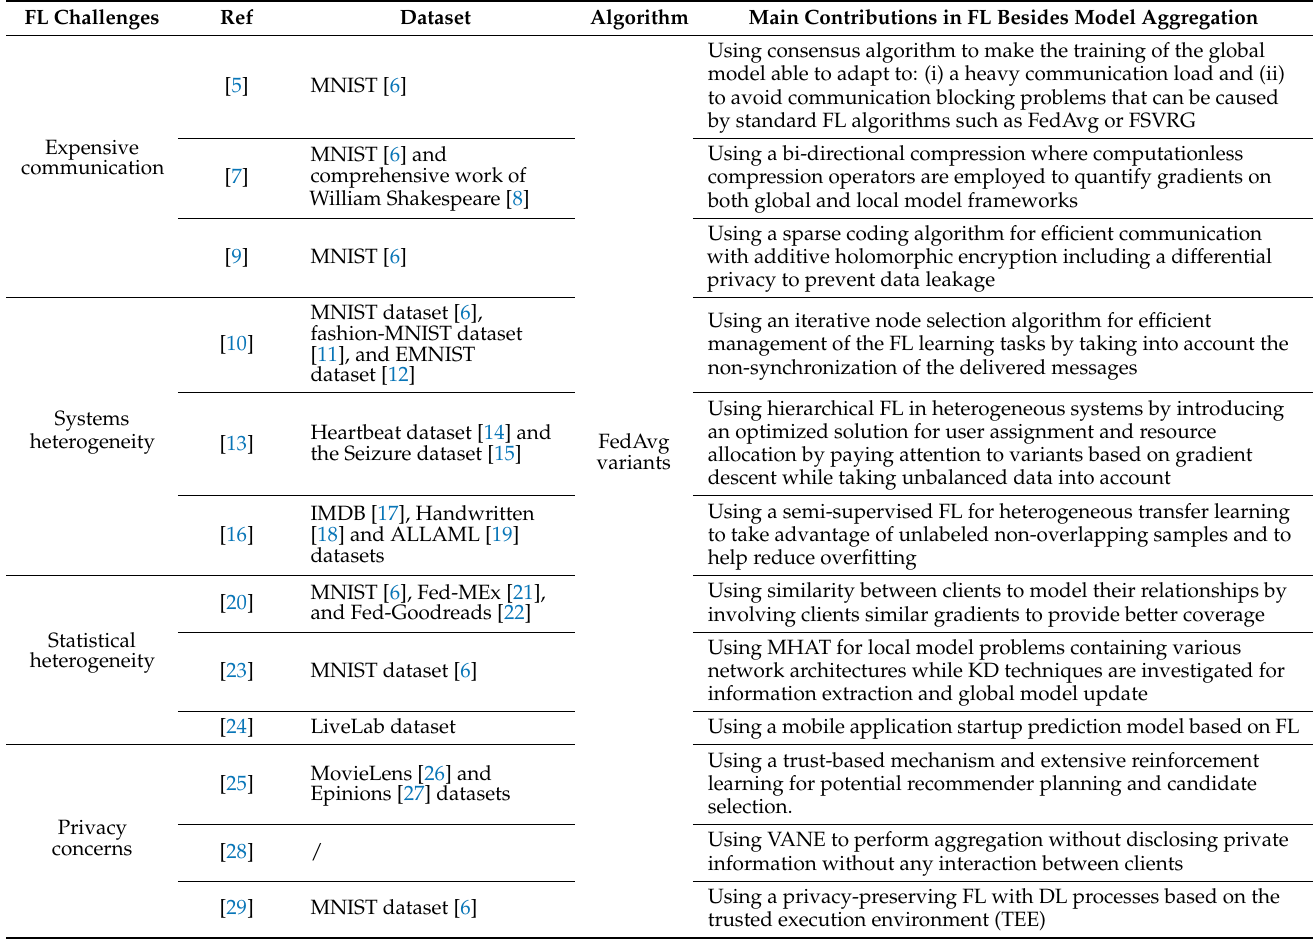
Table 1. Recent FL works introduced in the